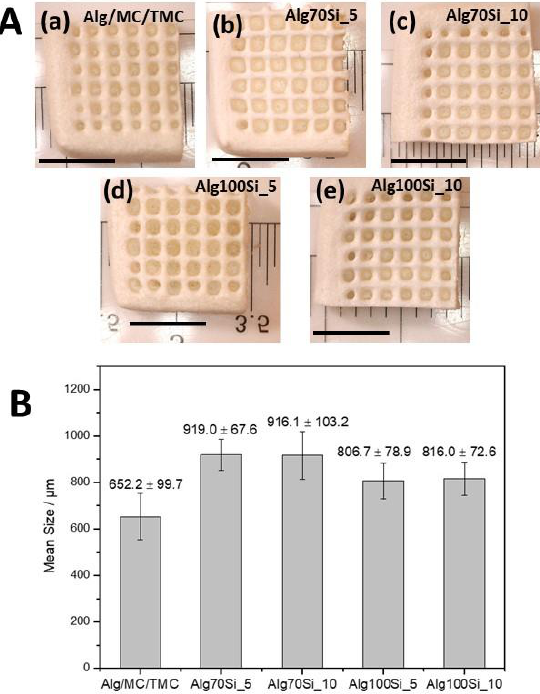
Figure 3. Optical microscope images of the lyophilized 3D-printed scaffolds according to formula- tions shown in Table 1 ( A ), and histogram showing the mean pore sizes of the scaffolds ( B ). Scale bar is equal to 5 mm.